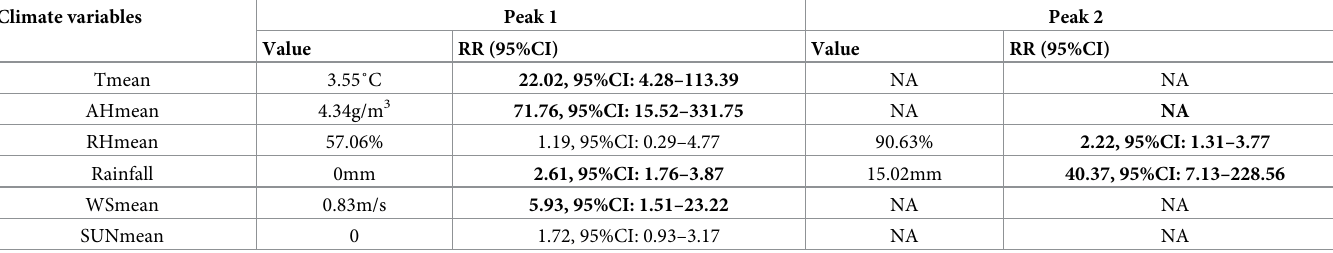
Table 3. The highest RRs for influenza activity and corresponding meteorological factors in Chongqing, China, 2012–2019. Climate